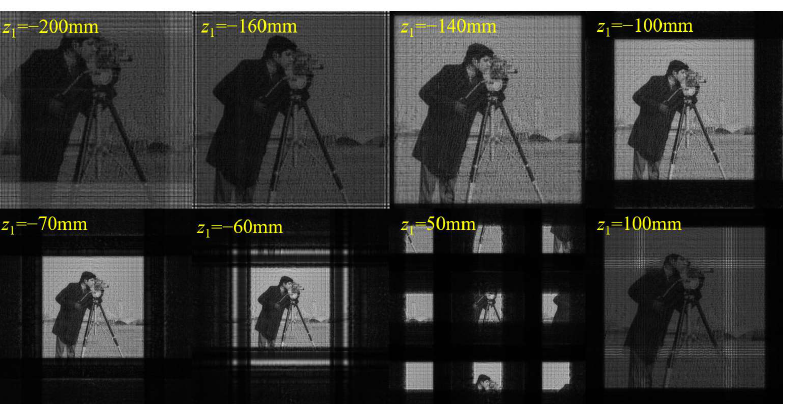
Figure 8. Calculated amplitude distributions on diffraction plane with different z 1 and fixed ∆ z = z 1 + z 2 = 750 mm using